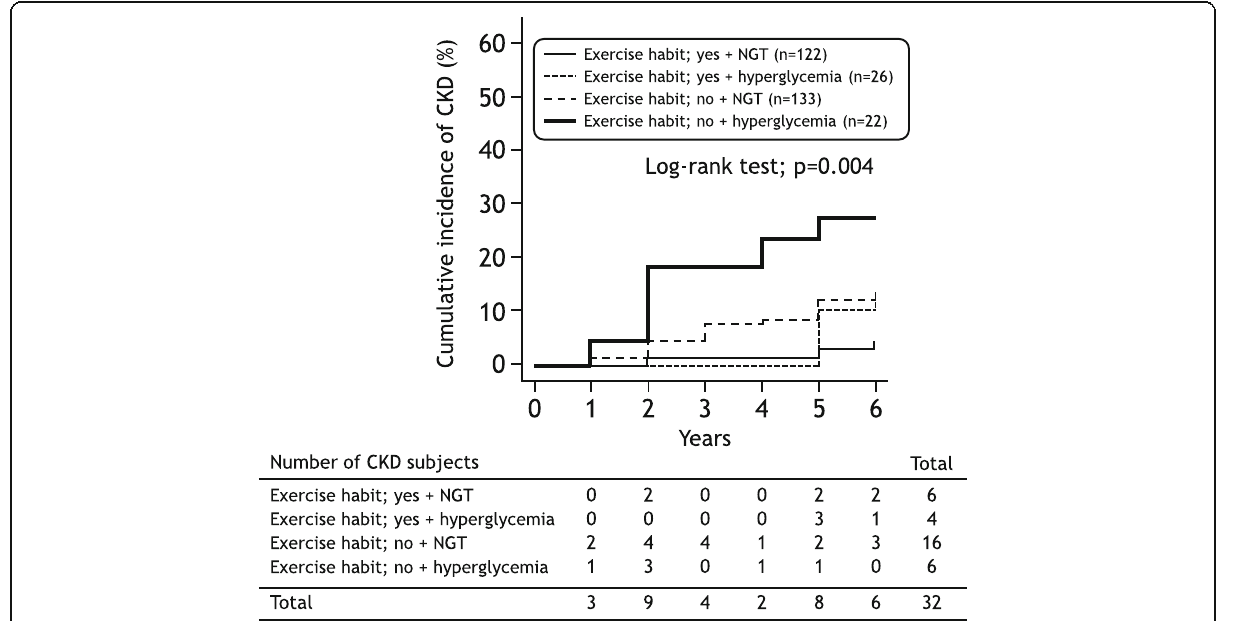
Fig. 3 The cumulative incidence of CKD after 6 years of follow-up according to the combination of habitual exercise (performance/non-performance) and hyperglycemia (presence/absence). NGT normal glucose